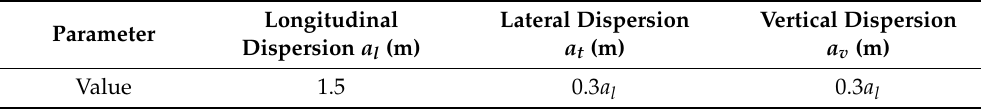
Table 5. Dispersion parameter table.